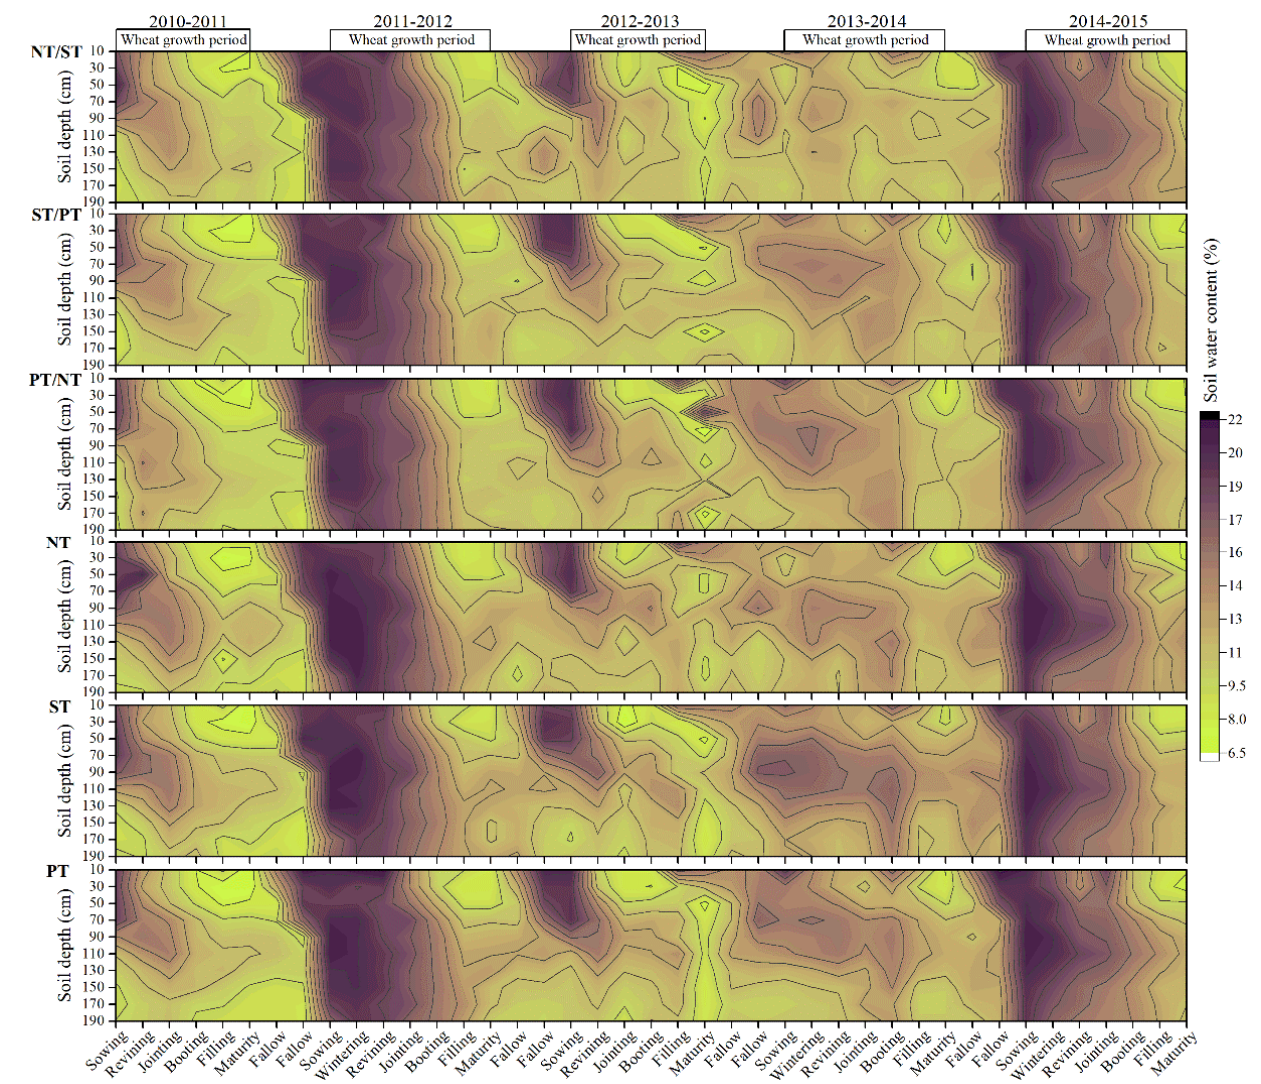
a significant difference at the 0.05 level among treatments.